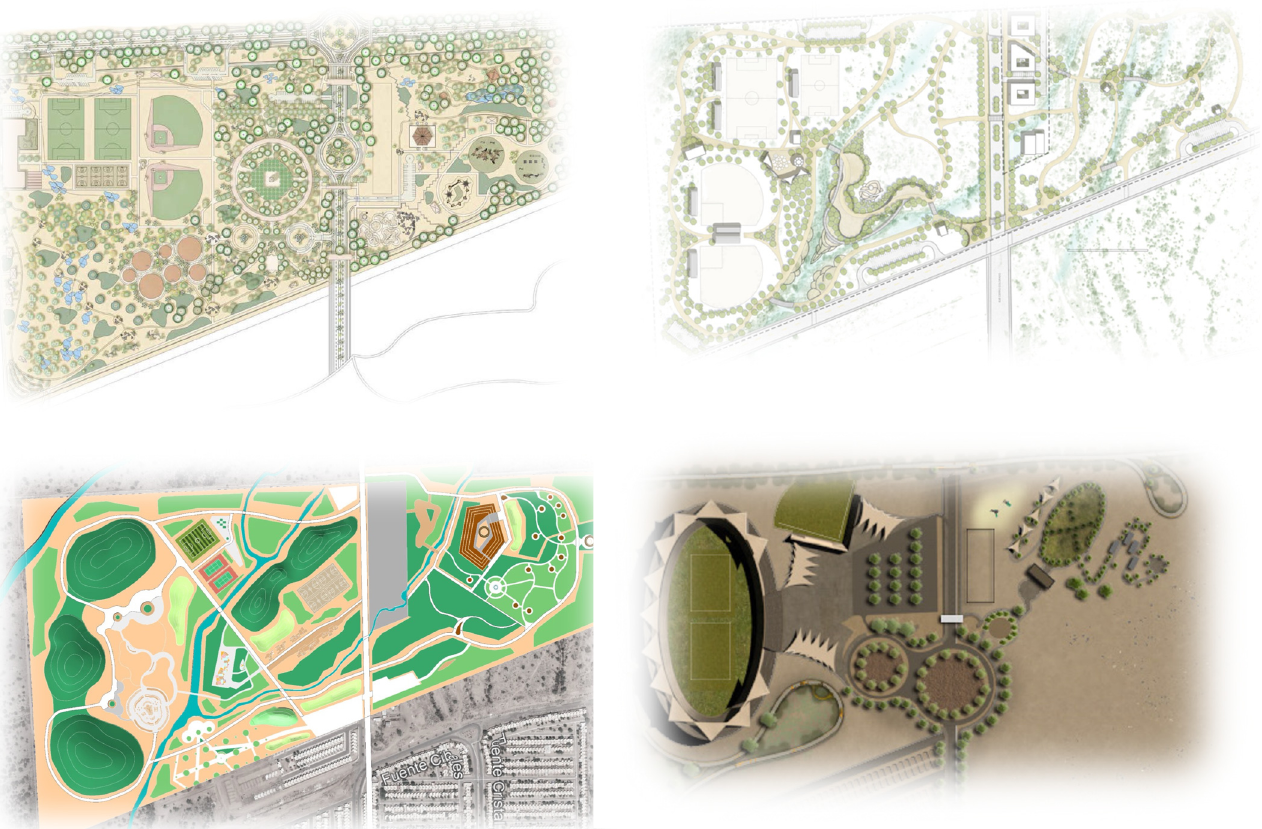
Figure 6. Four different design proposals (credit: landscape architecture students).